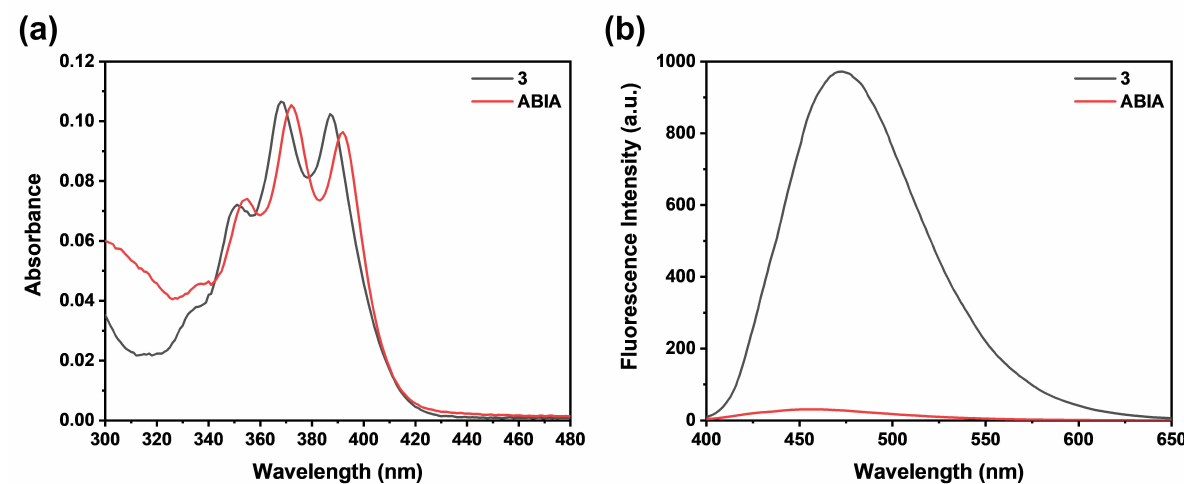
Figure 1. ( a ) UV-vis and ( b ) fluorescence emission spectra of compound 3 (10 µ M; λ ex = 368 nm) and the probe ABIA (10 µ M) in 90% DMSO:0.01 M HEPES buffer solution ( λ ex = 372